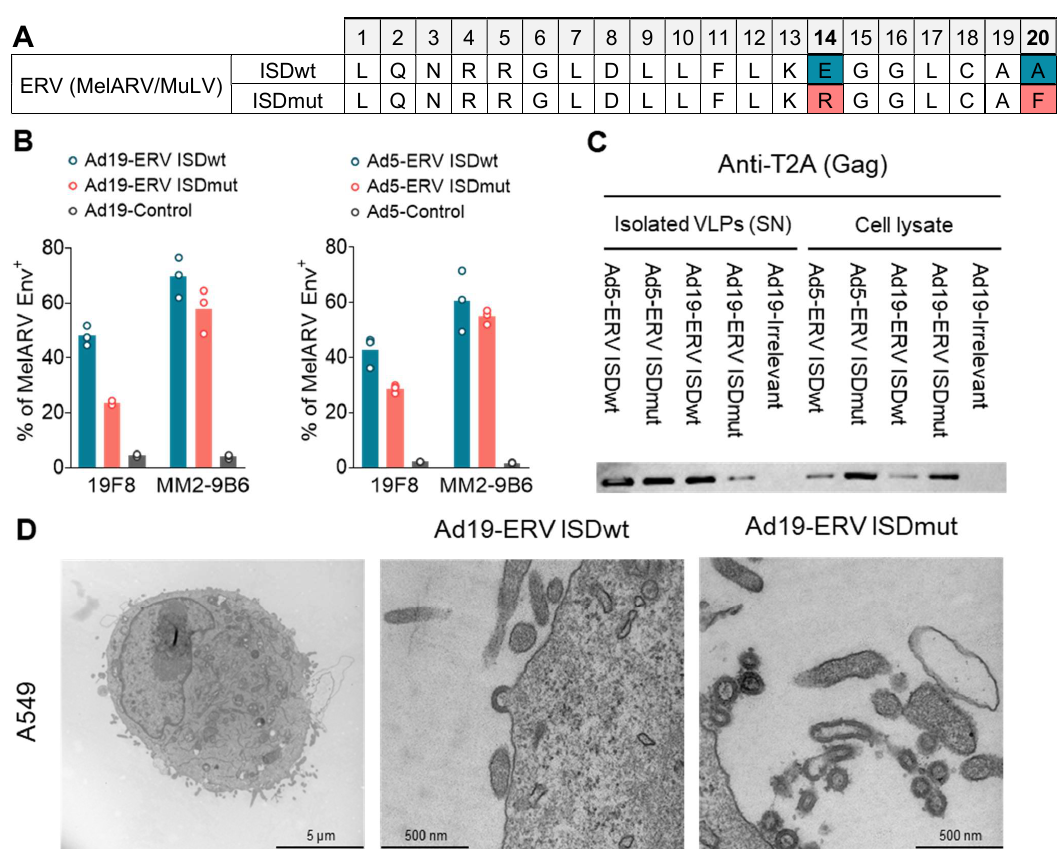
Figure 1. Vaccine characterization. ( A ) The prototype vaccine (ISDwt) was modified by substituting E14 R14 and A20 F20 in the ISD of MelARV Env sequence (ISDmut), as described in Schlecht- Louf et al. [23]. ( B – D ) Different mammalian cell lines were transduced with Ad19a/64 or Ad5-ERV ISDwt or ISDmut and were analysed for the expression of MelARV Env or Gag, as well as VLP formation and secretion. Adenoviral vaccines encoding an irrelevant transgene or no transgene (empty vector) were used as negative controls when transducing the cell lines. ( B ) Expression of the vaccine-encoded MelARV Env subunits on the surface of A549 cells 24 h post transduction. The primary antibodies 19F8 and MM2-9B6 were used to detect the respective Env subunits p15E/TM (ISD) and gp70/SU, by flow cytometry. ( C ) Expression and release of the vaccine-encoded MelARV Gag protein (detected by anti-P2A) as shown by Western blot after 48 h in cell lysates and VLPs purified form cell culture supernatants of transduced Vero cells. ( D ) Visualization of budding VLPs (circles of approximately 100 nm) in A549 cells at 48 h after transduction with Ad19a/64-ERV vaccines. Images were generated by TEM. Ad19a/64 is referred as Ad19 in the figure.